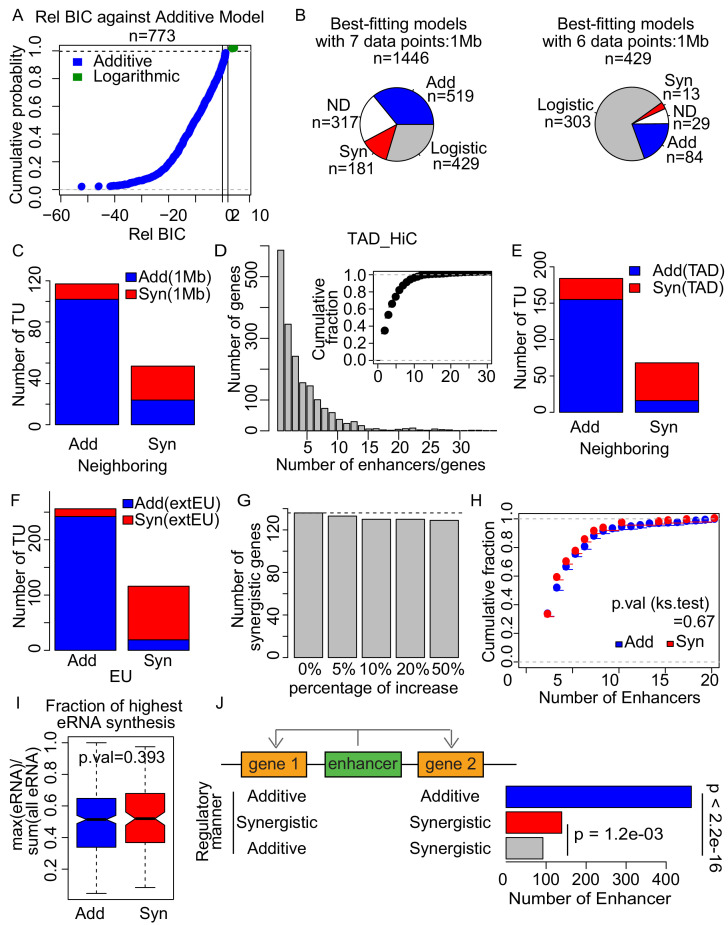
Enhancer synergy is a robust phenomenon.(A) The relative Bayesian Information Criterion (BIC) of logarithmic model against additive model. The logarithmic model fitted better only for a few tested loci, showing a relative BIC greater than 2 (green) showing distinct curve shape from Figure 5C. (B) Using the 1 Mb pairing, each of the tested genes was assigned to three theoretical models according to the BIC with seven data points (upper). BIC of the genes that were best fitted with logistic model were recalculated with six data points, without the data point with the highest sum of enhancer activities (lower). Numbers of the genes assigned with the indicated models are depicted. (C) Overlap of additive and synergistic enhancers obtained from neighboring and 1 Mb methods. (D) 68.9% of genes are regulated by more than one enhancer when using the TAD method. (E) Overlap of additive and synergistic enhancers obtained from neighboring and TAD methods. (F) Overlap of additive and synergistic enhancers obtained using 7624 EUs defined by H3K4me1 ChIP-seq and ATAC-seq signals (indicated as EU) and 15487 extended EUs defined by TT-seq signals regardless of epigenetic state (indicated as extEU) (Materials and methods). (G) Number of synergistic enhancers obtained using simulatively increased eRNA transcription level. (H) Fraction of additive (blue) or synergistic (red) genes paired with different numbers of enhancers. (I) Fraction of the maximum (highest) eRNA synthesis to the total eRNA signal for all paired enhancers of each gene. (J) Number of enhancers regulating two genes in the indicated regulatory manner. Nearest pairing method was used. p-values from binomial test are indicated.